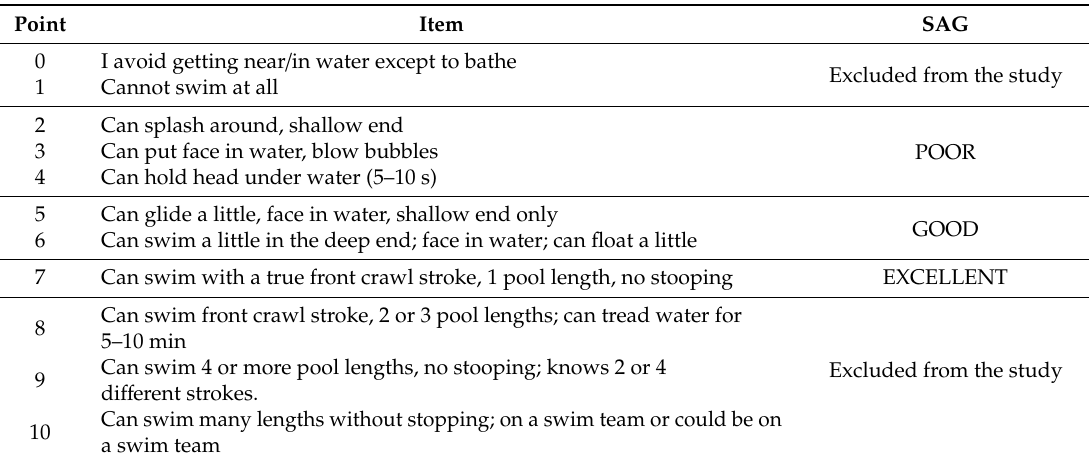
Table 1. Swimming ability scale by